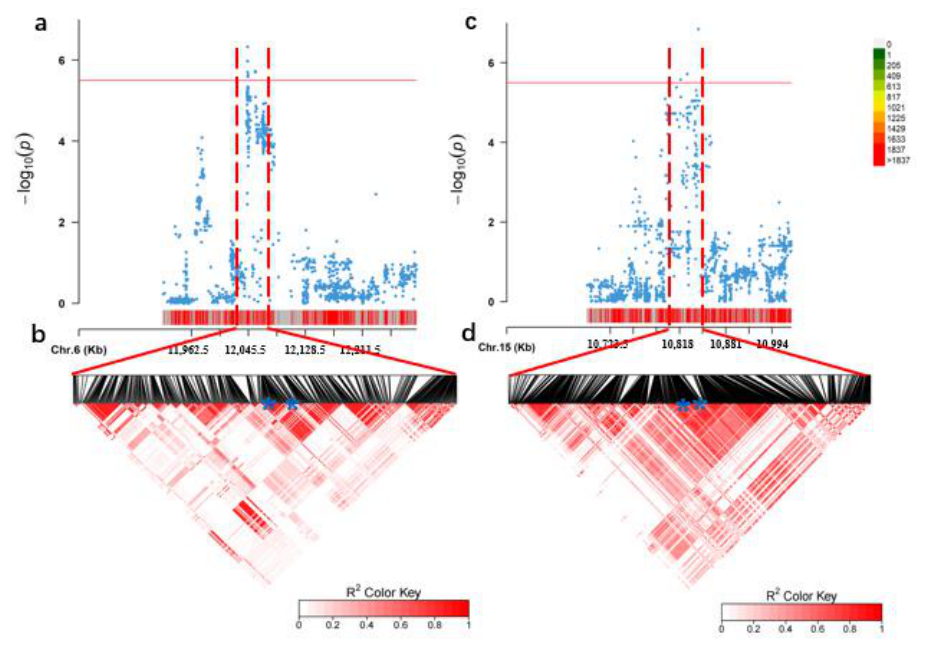
Figure 3. LD analysis between significant SNPs on chromosome 6 and chromosome 15. ( a ) Significant GWAS signal for the total soluble sugar on chromosome 6. ( b ) Pairwise LD analysis between significant SNPs on chromosome 6. ( c ) Significant GWAS signal for the total soluble sugar on chromosome 15. ( d ) Pairwise LD analysis between significant SNPs on chromosome 15. The LD plot is represented by the inverted triangle. The LD level between SNPs was indexed by the R2 value. * on chromosome 6 indicates the position of S06_12044239 and S06_12048607 in ( b ). * on chromosome 15 indicates the position of S15_10810881 and S15_10843821 in ( d ).